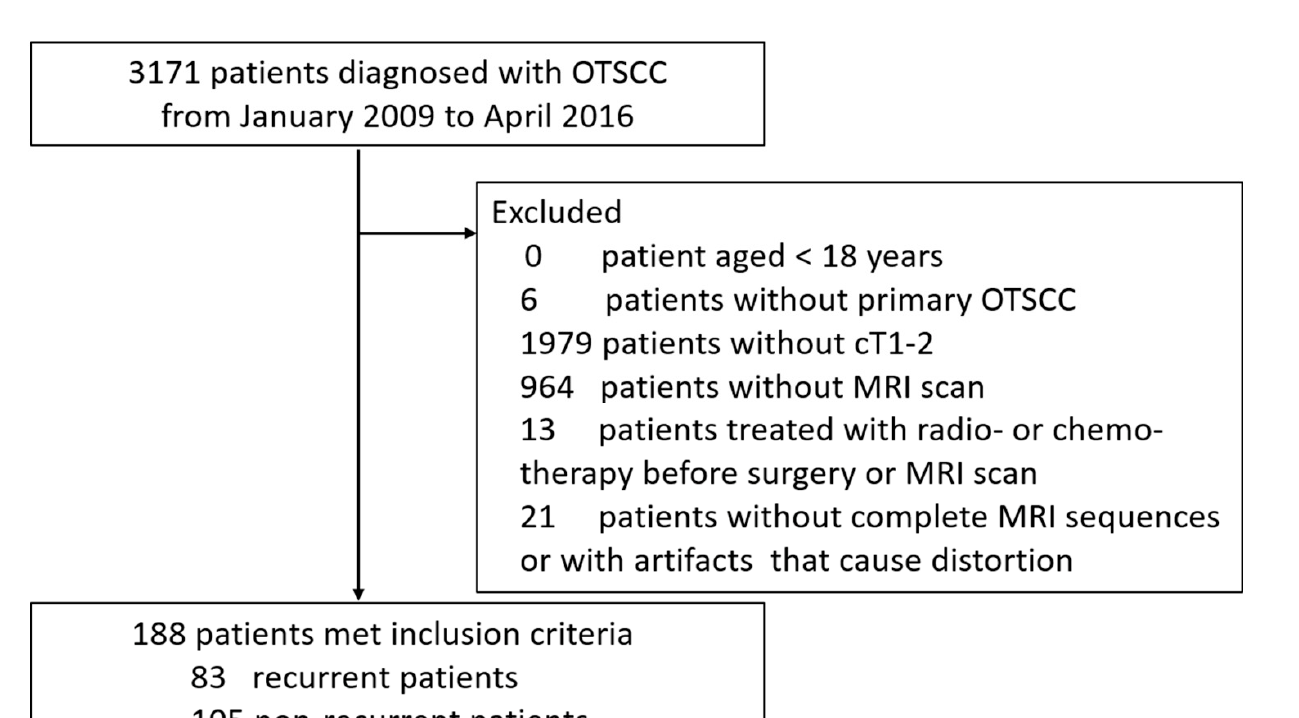
Figure 1. Patient exclusion flowchart.